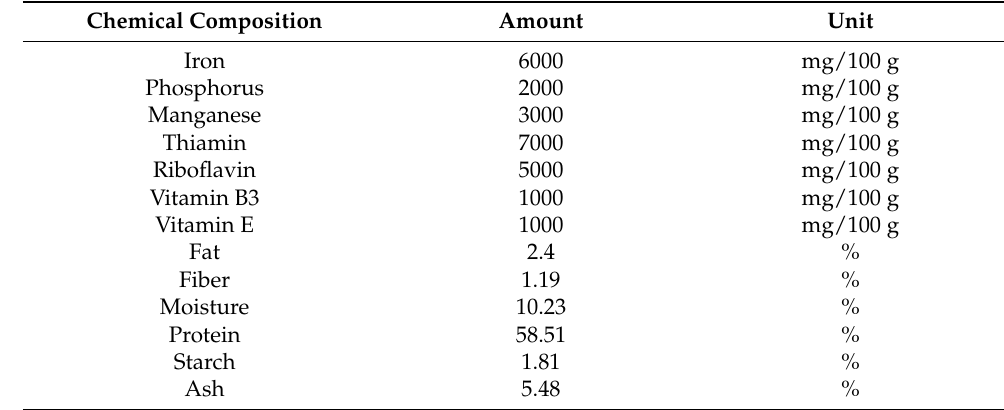
Table 1. Chemical composition of Spirulina platensis powder